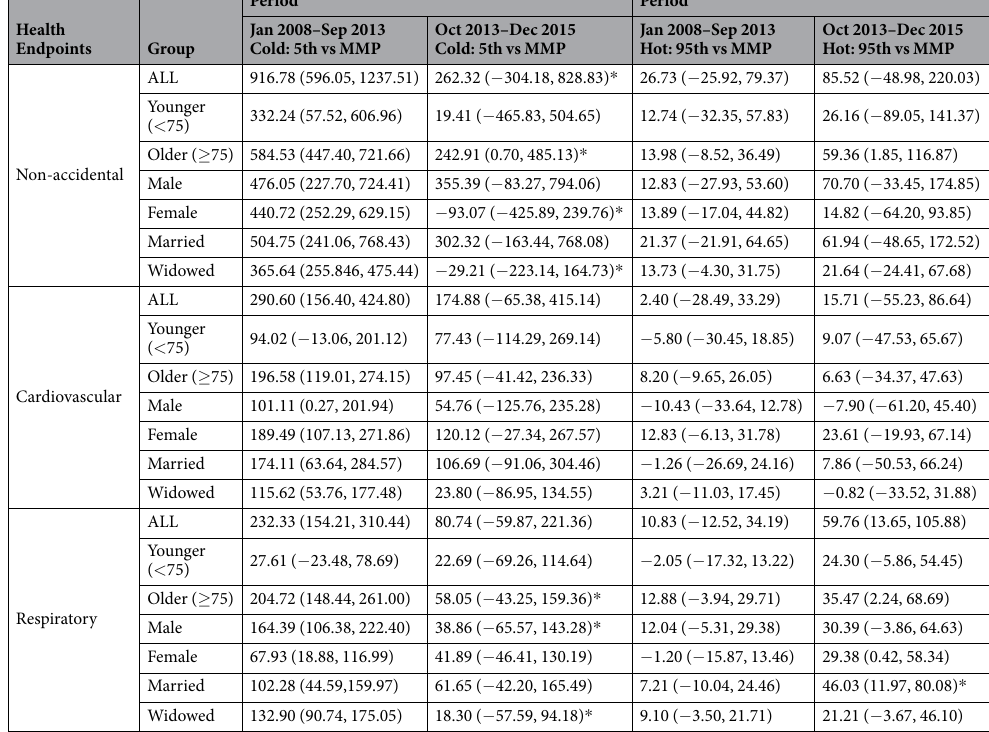
Table 2. The cumulative cold and hot effects on years of life lost due to non-accidental, cardiovascular, and respiratory mortality. MMP: minimum mortality percentile; The MMP for YLL of non-accidental, cardiovascular and respiratory mortality were 87, 83 and 79 percentiles, respectively. The 5th and 95th percentiles temperatures were 3.0 °C and 30.4 °C. * P < 0.05 (comparison between two